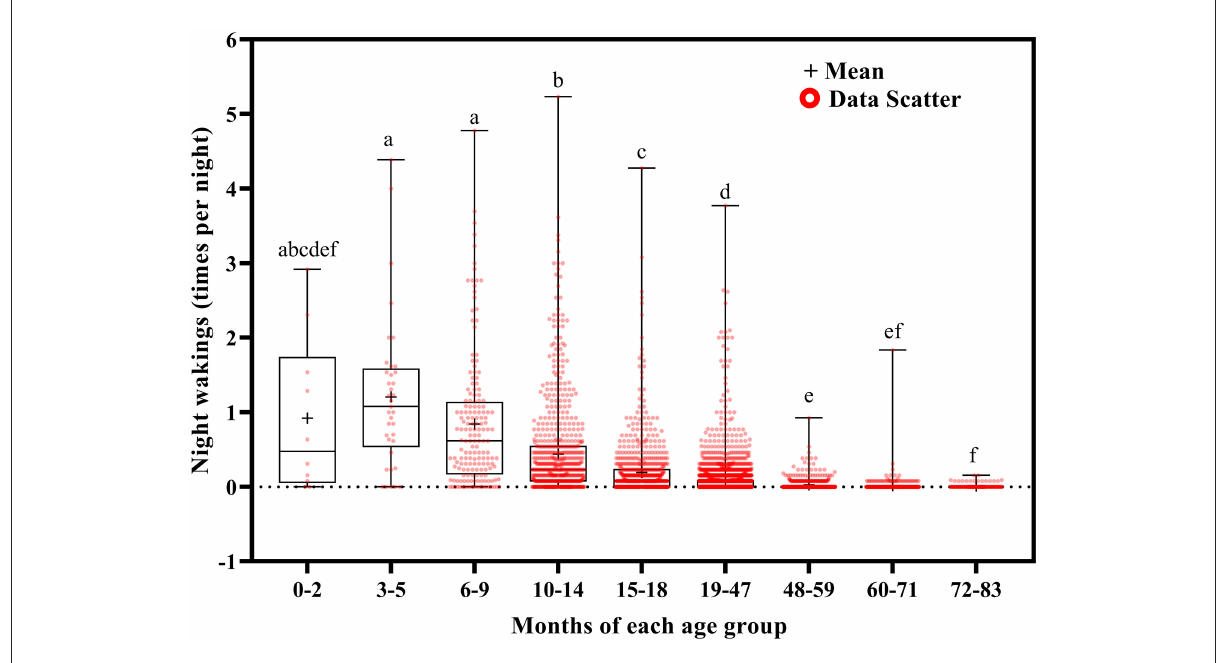
FIGURE8 Results of the one-way ANOVA for night wakings stratified by age.